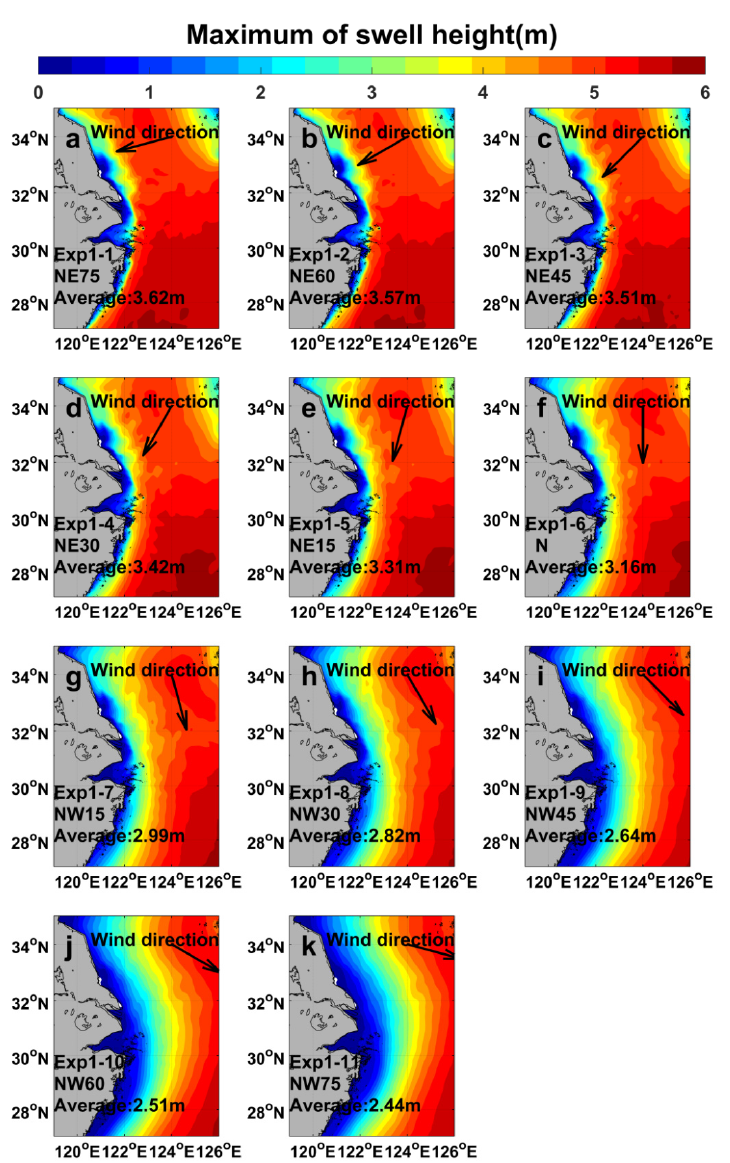
Figure 9. The distribution of MSH in the study region in ( a ) numerical experiment Exp 1-1, ( b ) nu- merical experiment Exp 1-2, ( c ) numerical experiment Exp 1-3, ( d ) numerical experiment Exp 1-4, ( e ) numerical experiment Exp 1-5, ( f ) numerical experiment Exp 1-6, ( g ) numerical experiment Exp 1-7, ( h ) numerical experiment Exp 1-8, ( i ) numerical experiment Exp 1-9, ( j ) numerical experiment Exp 1-10, ( k ) numerical experiment Exp 1-11. Spatial distribution of MSH is the same as that of the mixed waves. Mean MSH decreases as the wind direction changes from 75 ◦ N.E to 75 ◦